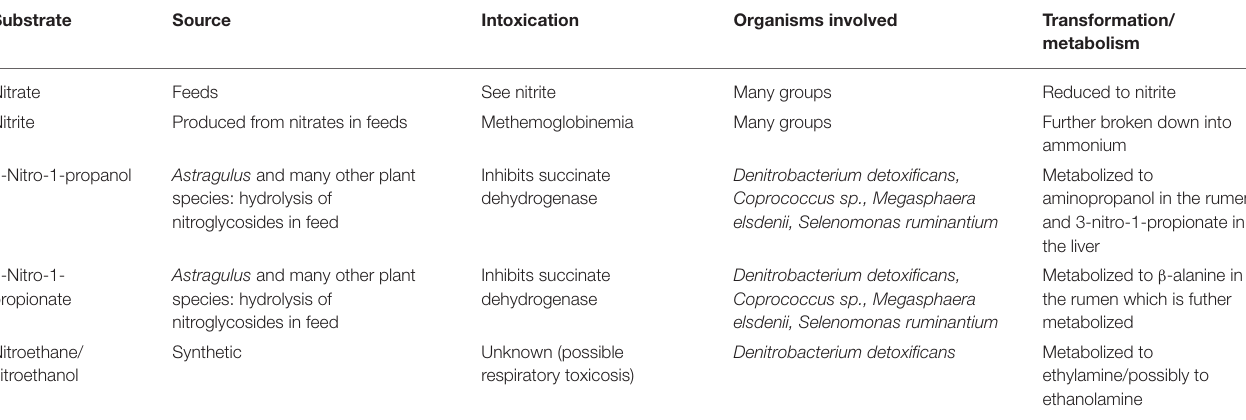
TABLE 3 | Summary of nitrate and nitrocompound